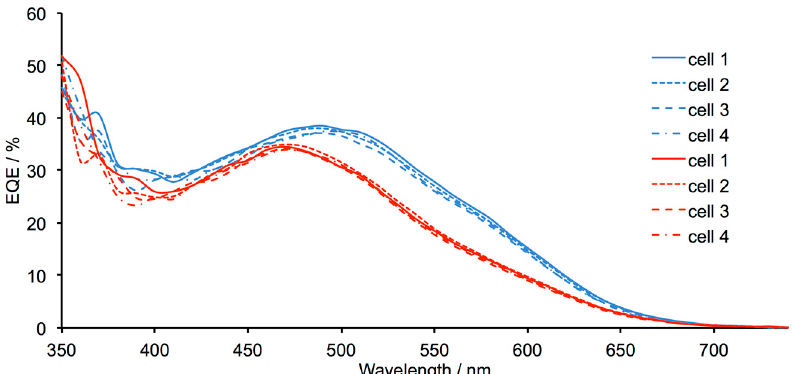
Figure 8. External quantum efficiency (EQE) spectra for sets of four DSCs sensitized with [Cu( 5 )( 1 )] + (blue curves) and [Cu( 5 )( 2 )] + (red curves) measured on the day of sealing the cells.